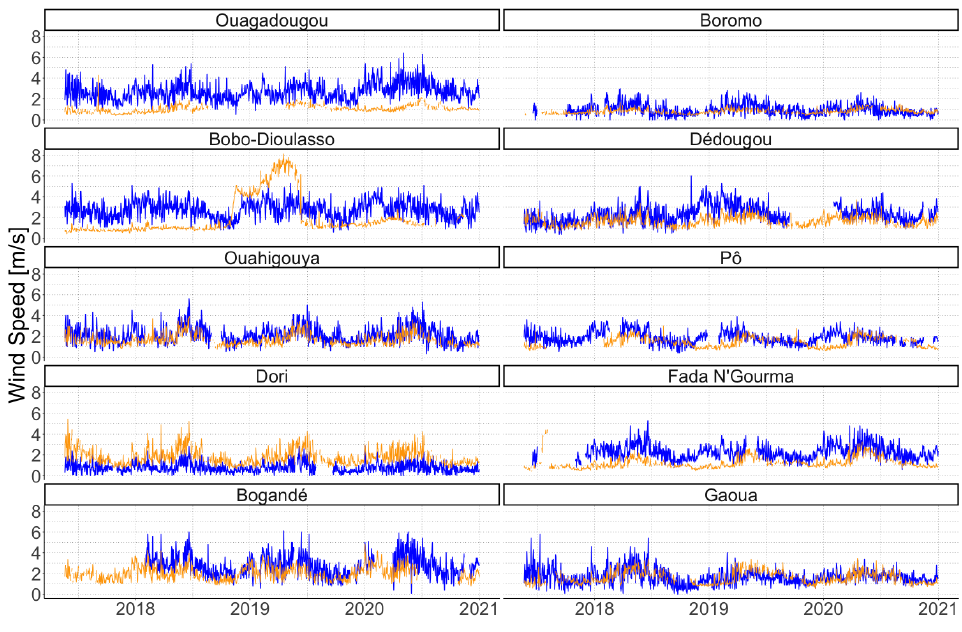
Figure 16. Comparison of wind speed time series between TAHMO stations in orange and the corresponding stations from meteorological service of Burkina Faso in